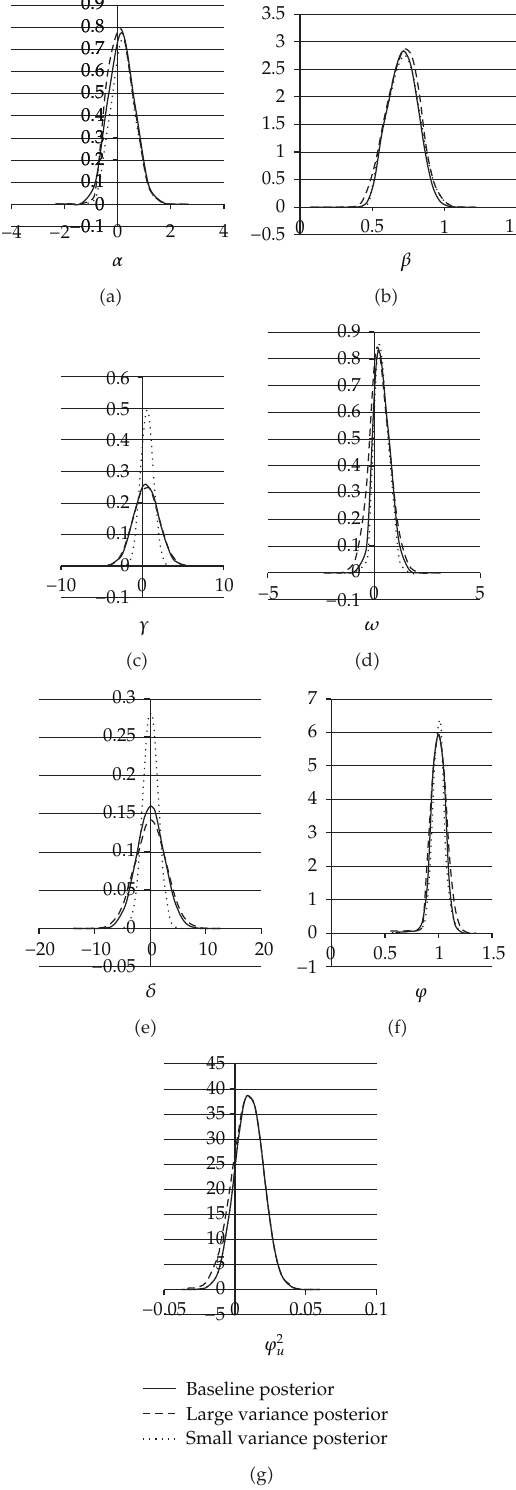
Figure 1: Dow-Jones: posterior density estimates and sensitivity